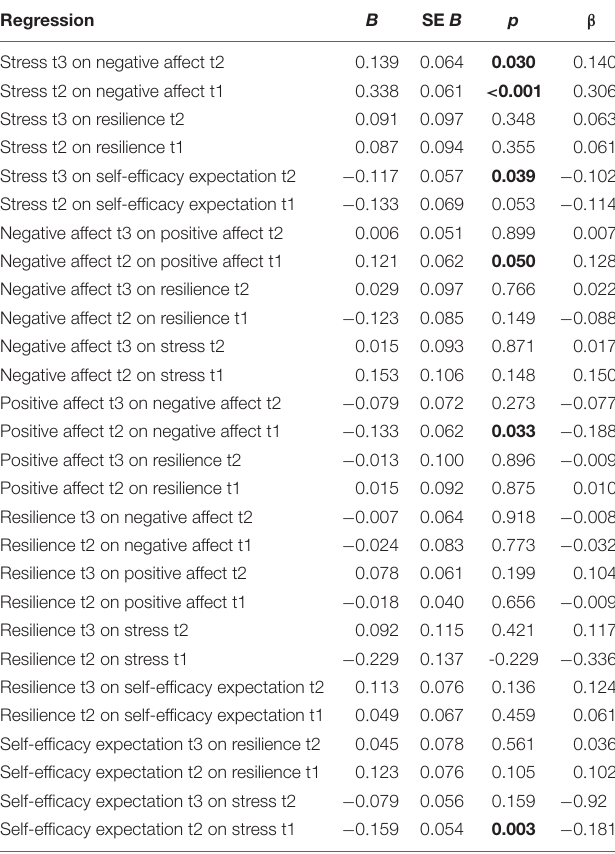
TABLE 3 | Unstandardized and standardized coefficients, standard errors, and p -values of the cross-shifted regressions.